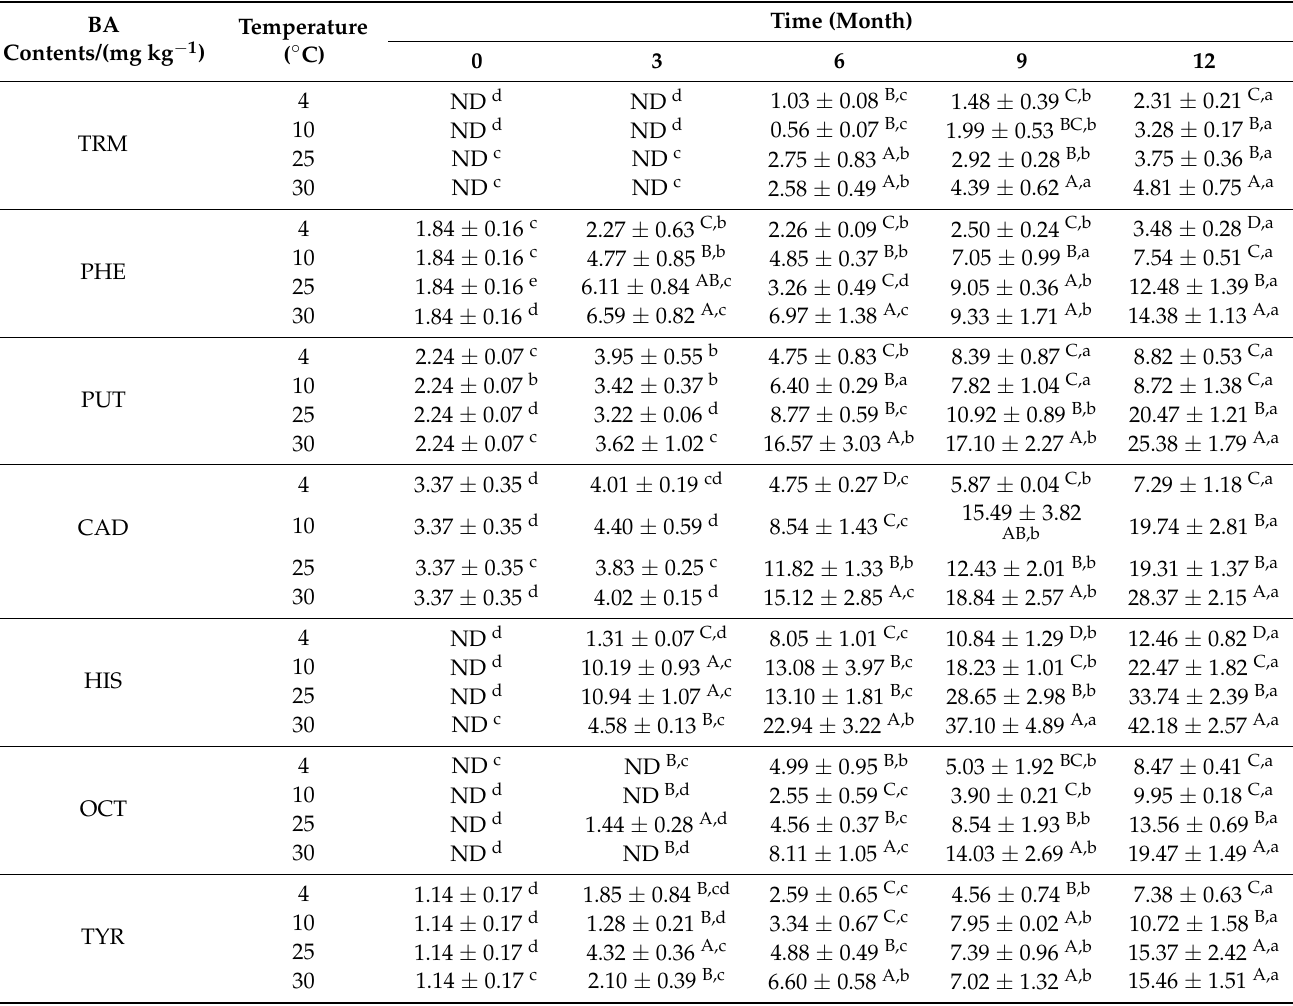
Table 3. Changes of BAs in canned mantis shrimp during storage at different